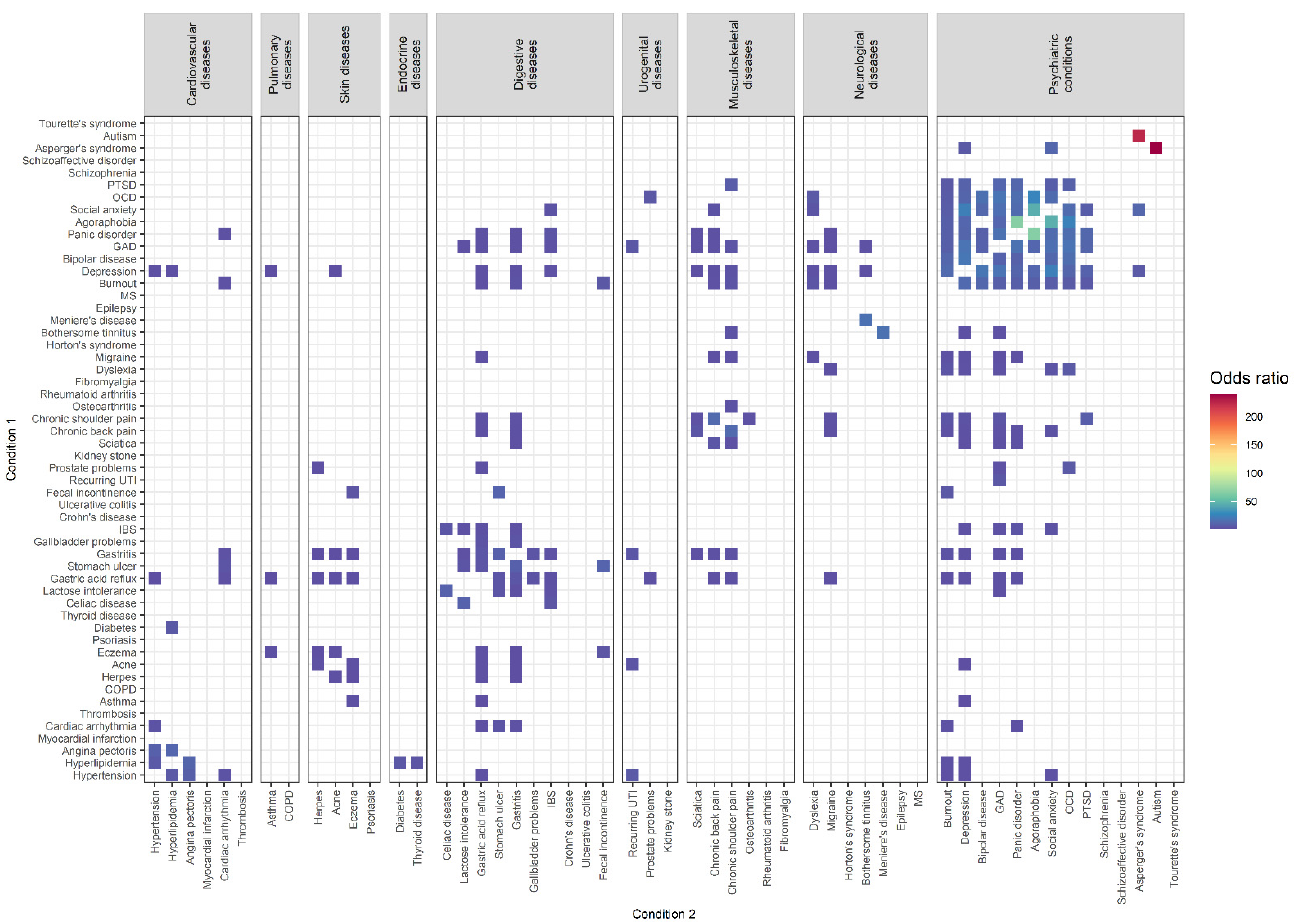
Figure 3. Comorbidity combinations of 54 conditions with increased odds ratios ( p < 0.05/5724) in male participants ( N = 11,949) based on the results of age-, education-, employment-, BMI-, and smoking-adjusted logistic regression analysis.